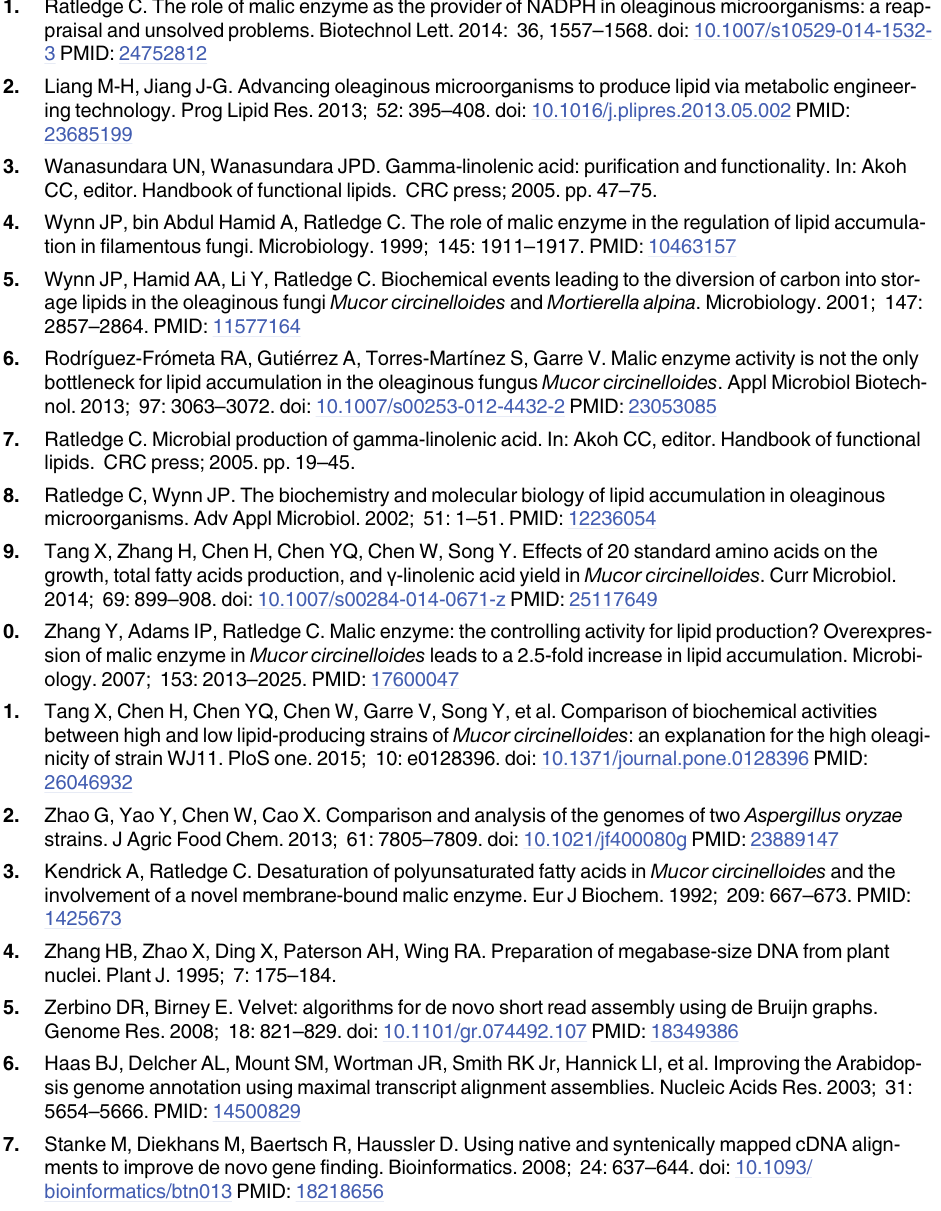
S4 Table. Listing of M . circinelloides CBS 277.49 specific genes as compared to M . circinel- loides